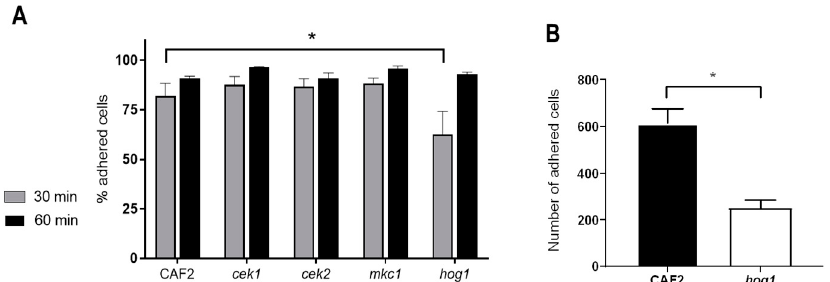
Figure 1. Adhesion to di ff erent surfaces of C. albicans strains defective in MAP kinases ( A ) C. albicans cells growing exponentially at 30 ◦ C were counted and inoculated into 24-wells polystyrene plates. The assay was performed in DMEM medium at 37 ◦ C and 5% CO 2 during 30 and 60 min. Adhered and non-adherent C. albicans cells were recovered and spread on YPD plates for CFUs counting. Data are the mean of four independent experiments and the error bars stand for SEM (Standard Error of the Mean). * p < 0.05. ( B ) Number of C. albicans cells adhered to plastic exposed to a continuous flow. C. albicans cells were inoculated in DMEM medium to a final concentration of 5 × 10 5 cells / mL and circulated within an ibidi flow system at 37 ◦ C and 5% CO 2 . Quantification of the cells was done microscopically analysing 80 di ff erent fields. The experiments were performed twice for each strain and the errors bars represent the